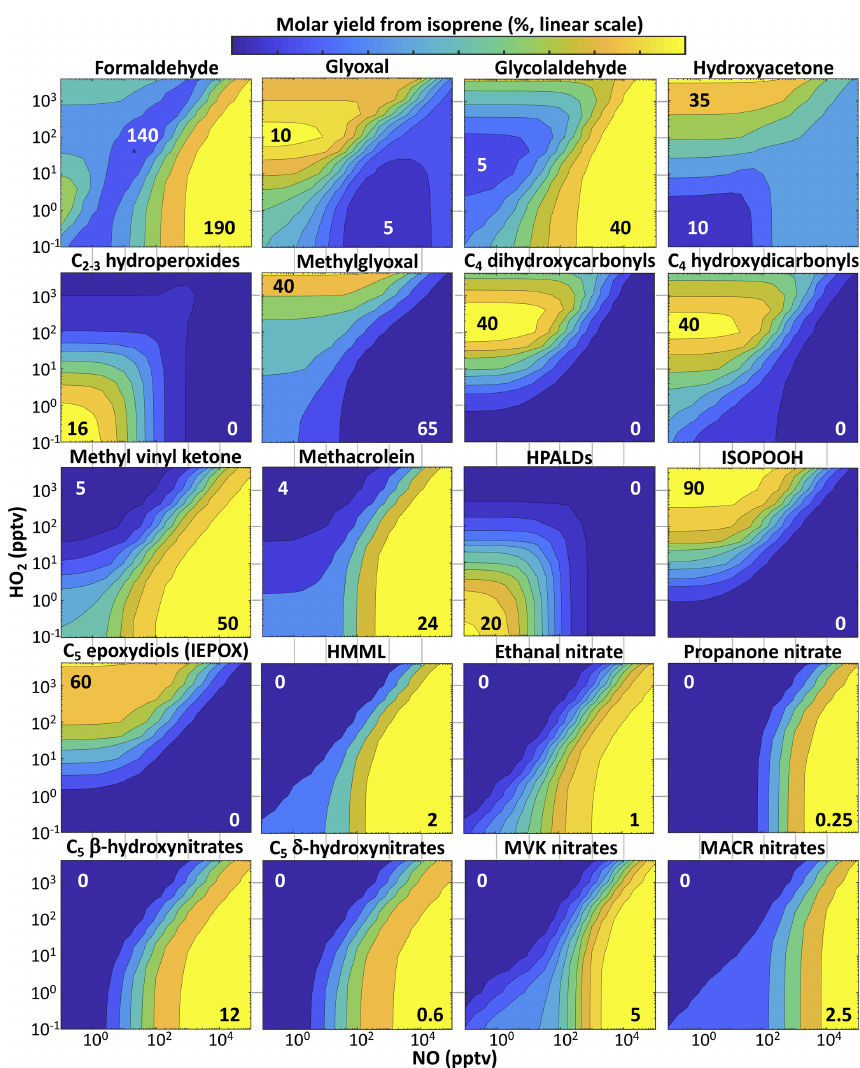
Figure 10. Percent yields of organic products from isoprene + OH oxidation as a function of NO and HO 2 . Results are from fixed-radical box model simulations with RCIM, run at 25 ◦ C for clear-sky equatorial radiation at solar noon and an ozone column of 350DU. The fixed-radical box model does not account for deposition or aerosol uptake. Contours are evenly spaced on a linear scale between the minimum values (in white) and maximum values (in black) located on each plot. HPALDs ≡ C 5 hydroperoxy-aldehydes. ISOPOOH: C 5 hydroxy-hydroperoxides. HMML: hydroxymethyl-methyl- α -lactone. MVK: methyl vinyl ketone. MACR: